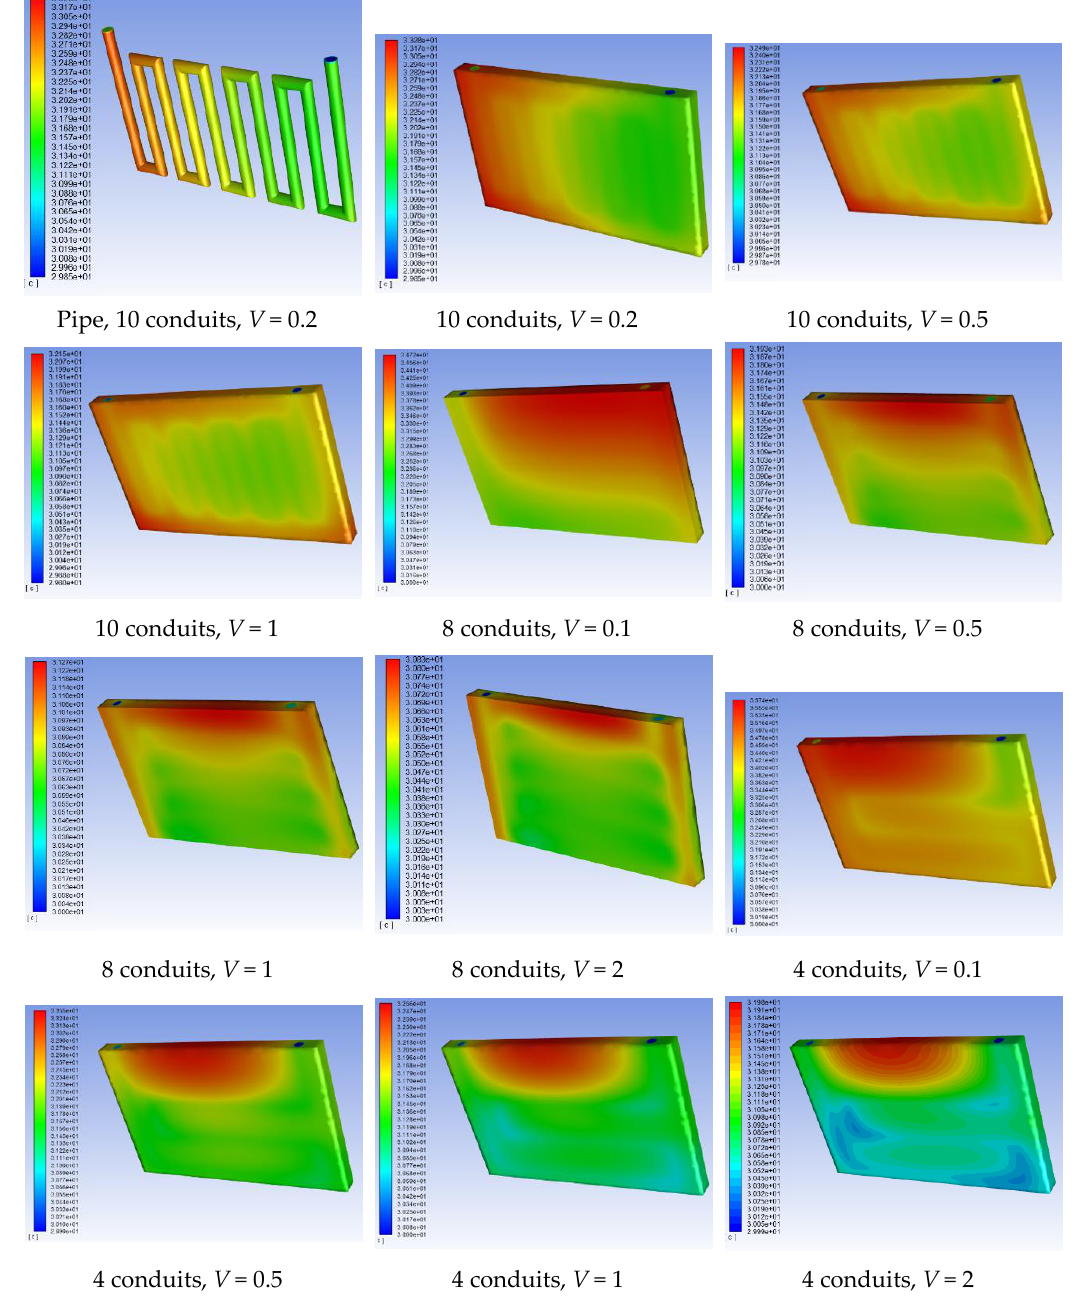
Figure 4. Temperature distribution of different design and inlet velocity.